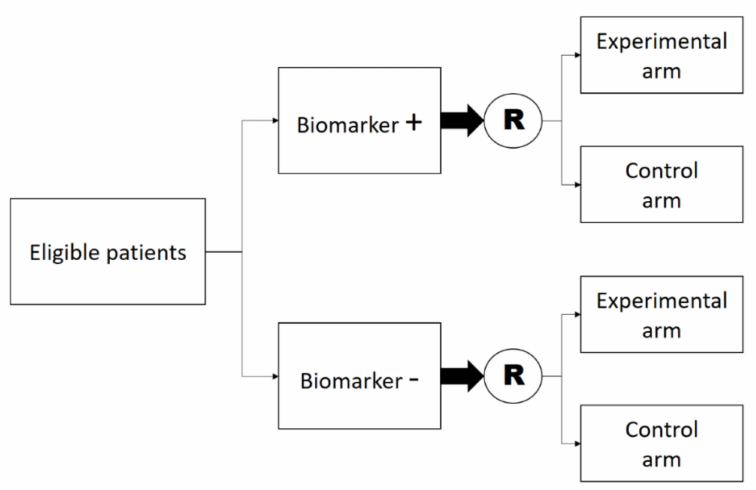
Figure 2. Generic design of a biomarker-stratified trial. “Biomarker + ” and “Biomarker − “ refer to patients with presence and absence of biomarker respectively, and “R” denotes